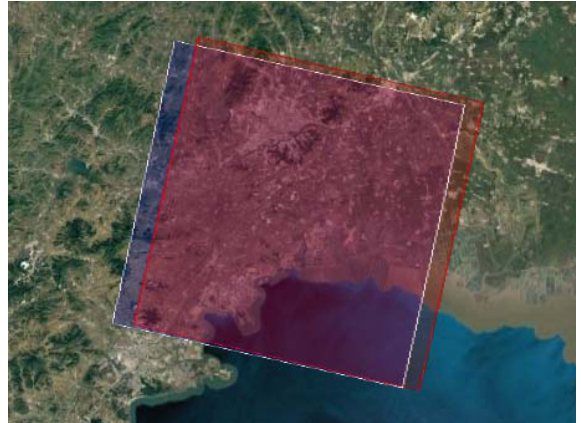
Figure 1. The cover range of the overlapping ZY-3(01) and ZY- 3(02) in the experiment Red:ZY-3(01), Blue:ZY-3(02)